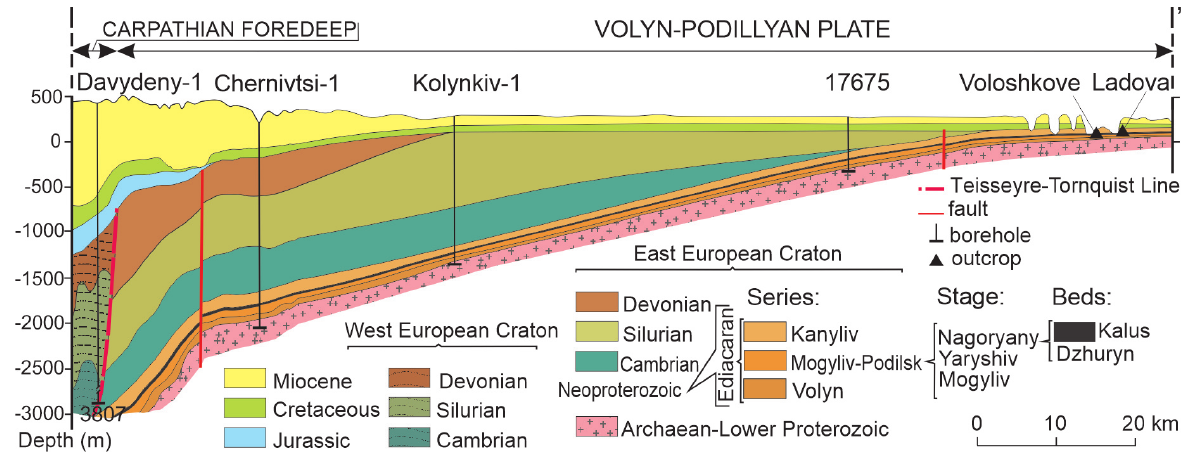
Fig. 2. Geological cross-section I – I’ through the Carpathian Foredeep and the Volyn-Podillyan Plate (see Fig. 1 for location) (modified after Vashchenko et al. 2007; Bratslavskiy et al.